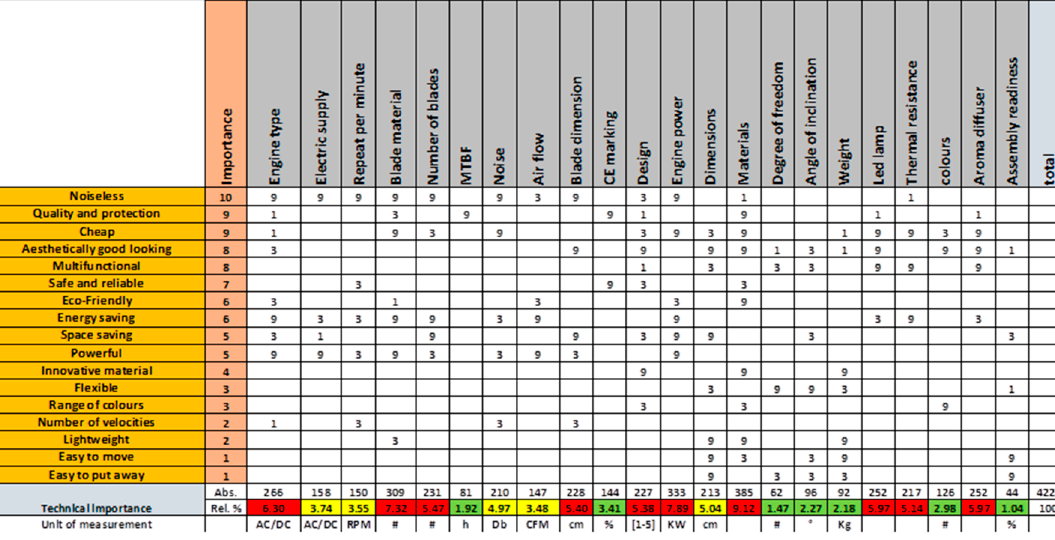
Figure 6. Relationship matrix.